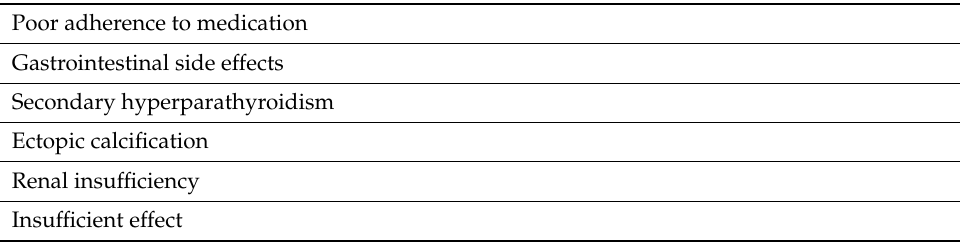
Table 1. Problems of conventional treatments in adult XLH